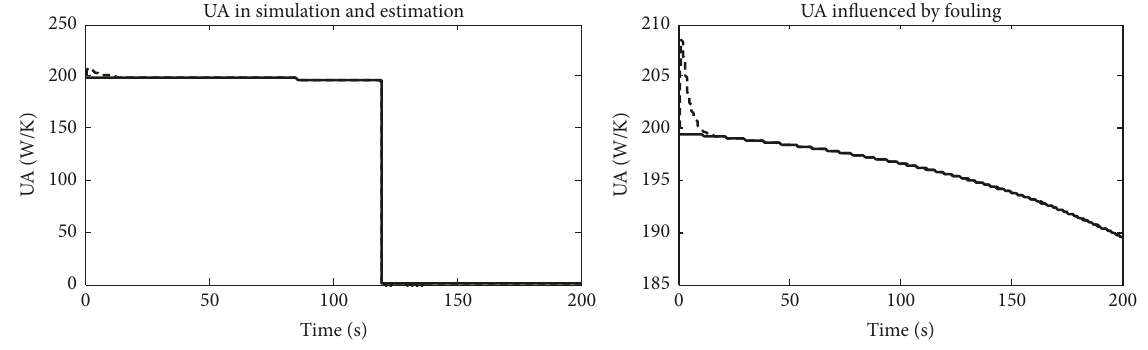
Figure 12: Estimation and simulation under fault